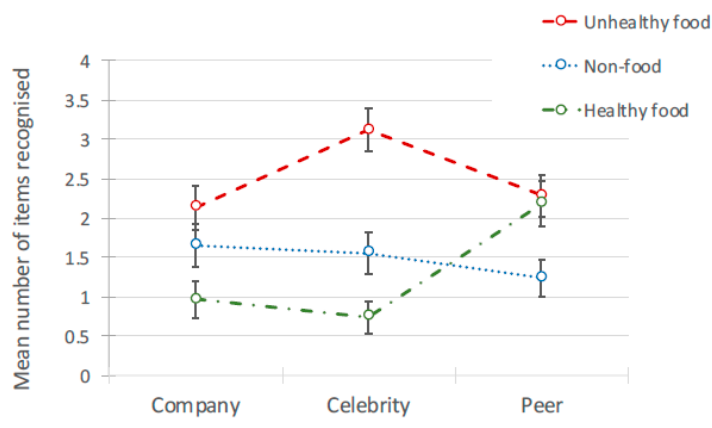
Figure 9. Interaction between prompted brand recognition and source of ad for 3 types of ad.